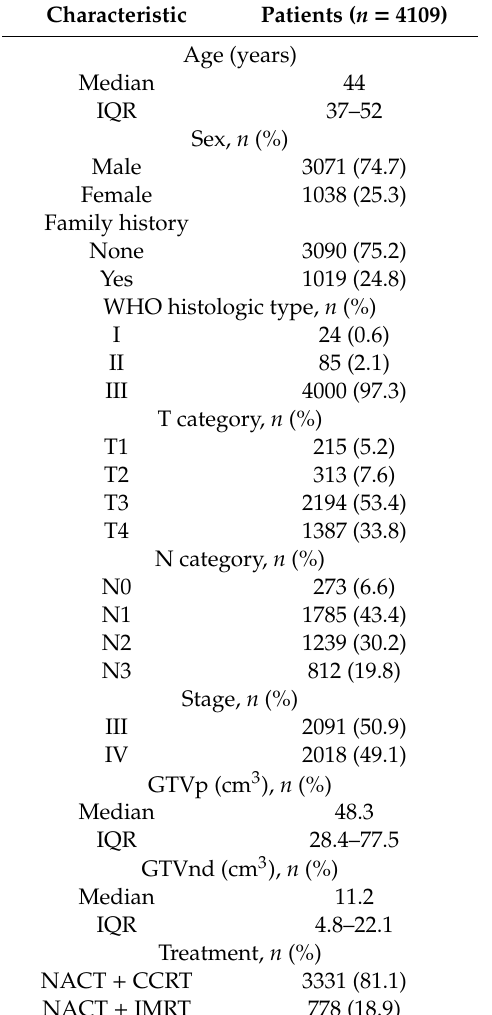
Table 1. General